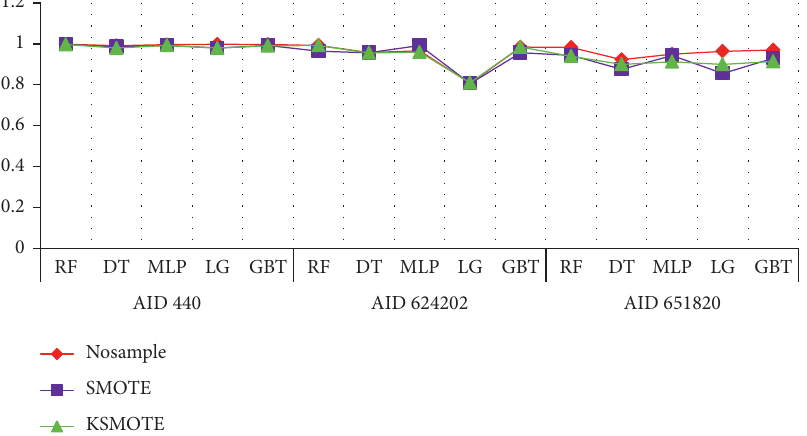
Figure 9: Specificity of all datasets for the PaDEL descriptor.